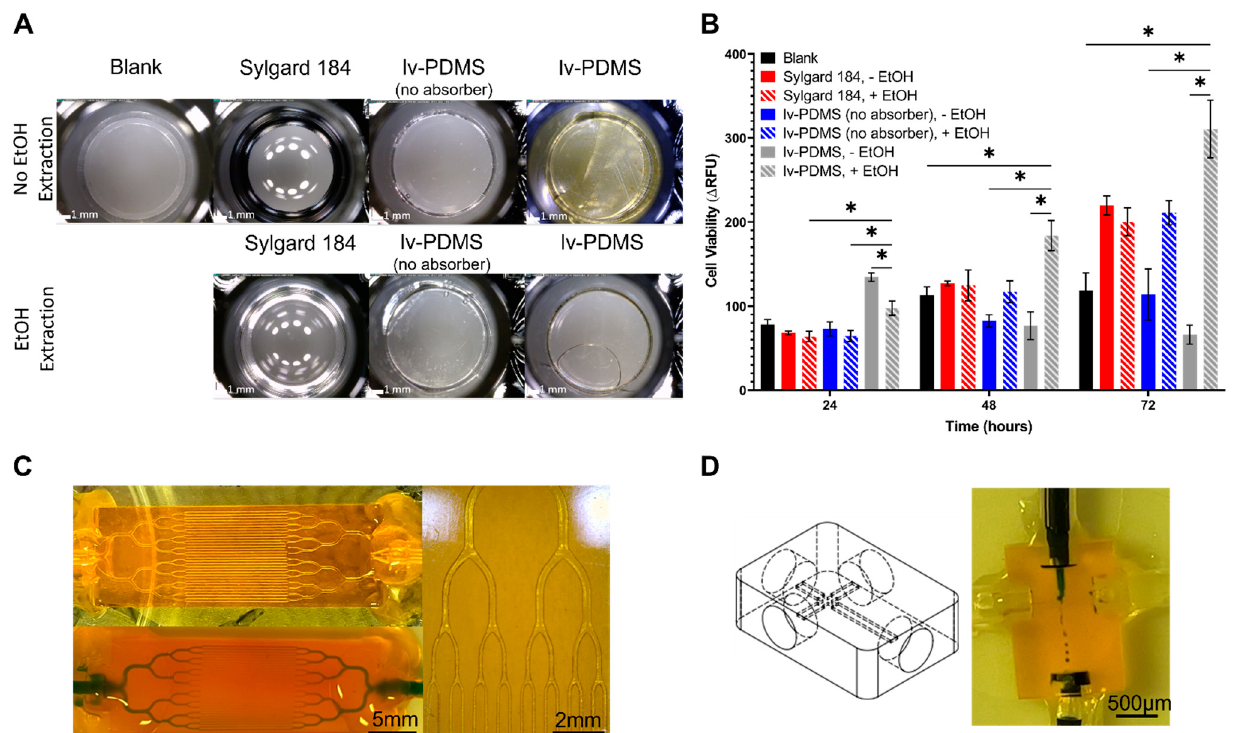
Figure 6. ( A ) Top-down view of a 96-well plate with polymer discs at the base of the well (no cells). Samples had no EtOH extraction and a 72 h EtOH extraction. ( B ) Cell viability of HepG2 cells grown on blank wells, Sylgard 184, lv-PDMS (no absorber), and lv-PDMS. All polymer samples were extracted with ethanol (+EtOH) or not extracted (-EtOH) ( n = 3). A 2-way ANOVA with Tukey’s multiple comparison test determined a significant interaction ( p < 0.0001) between the effects of treatment (control, untreated, and extracted) and time (24 h, 48 h, and 72 h) on cell viability ( Δ RFU). Tukey’s multiple comparisons for all sample combinations can be found in Table S3. Only comparisons with (* indicates p < 0.05) for the EtOH-extracted lv-PDMS resin are denoted on the plot for sake of brevity. ( C ) Biomimetic branching network of 200 µm tall capillaries (top) and device with blue food dye flowed through (bottom). Zoomed-in image of microchannels void of resin (right). ( D ) Droplet generator with 200 µm tall channels. CAD rendering (left) showing internal channels and droplets were composed of blue-food-dyed water in oil (right).